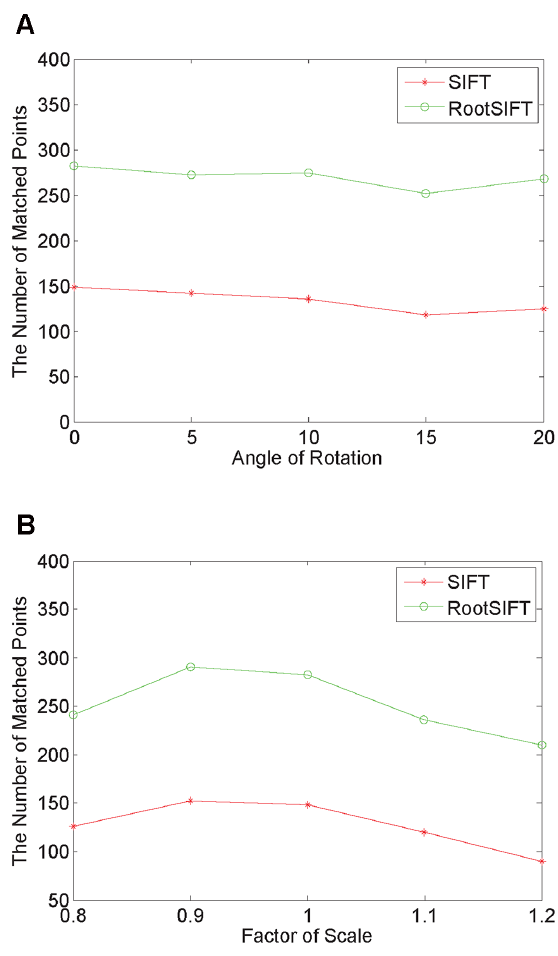
Figure 6. Robustness of SIFT and RootSIFT against rotation and scale transformations. (a) Robustness of SIFT and RootSIFT against rotation transformation; (b) Robustness of SIFT and RootSIFT against scale transformation.